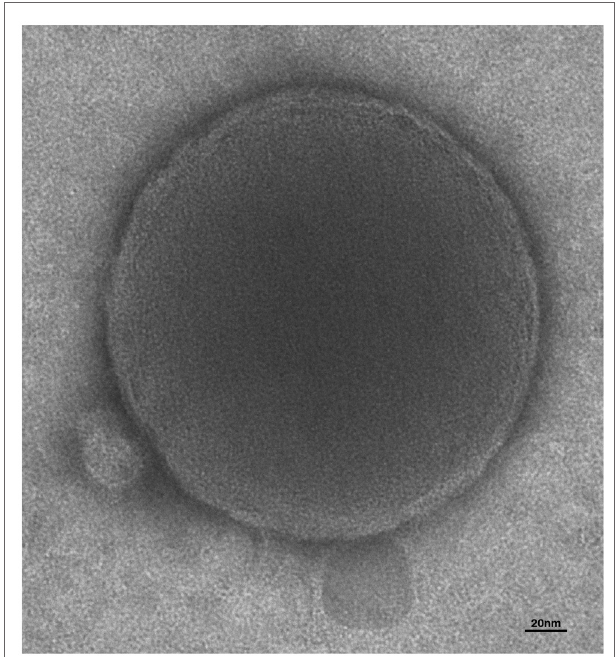
FiGURe 1 | electron microscopy of extracellular vesicles. The human microglia cell line, CHME-5 was stimulated with ATP to induce release of EVs. Supernatant was analyzed by transmission electron microscopy. Integrity, round shape, and lipid bilayer of the membrane (approximately 7 nm) can be appreciated from the picture of this shed vesicle of about 250 nm of